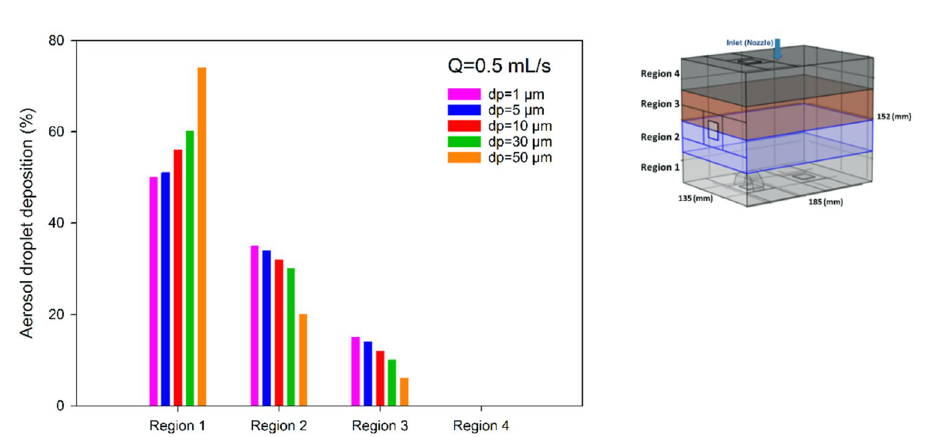
Figure 8. Comparison of the simulated deposition of the aerosol droplets with different diameters (d p ) in four regions in the CFD box model. Deposition in region 4 (ventral) was